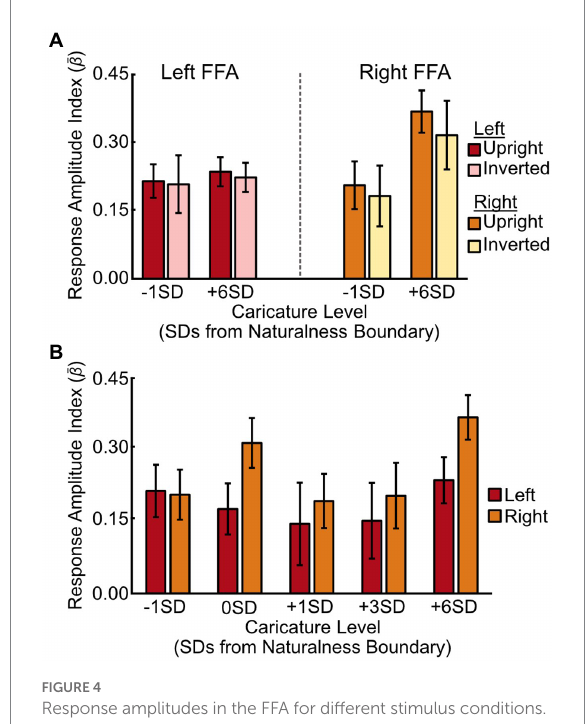
FIGURE 4 Response amplitudes in the FFA for different stimulus conditions. (A) Average response amplitude in the left (red/pink) and right (orange/yellow) FFA to the most (+6SD) and least (-1SD) caricatured faces in both the upright and inverted conditions. (B) Average response amplitudes in the left (red) and right (orange) FFA to each of the five caricature conditions for the upright stimuli only. Bars are grouped according to deviations from the average naturalness boundary (-1SD, closer to the average face; +6SD is highly caricatured). Y axes show the response amplitude index, measured by offsetting the β coefficients from the deconvolution analysis by t 0 , and averaging t 1-4 . Error bars show ± 1 SEM across